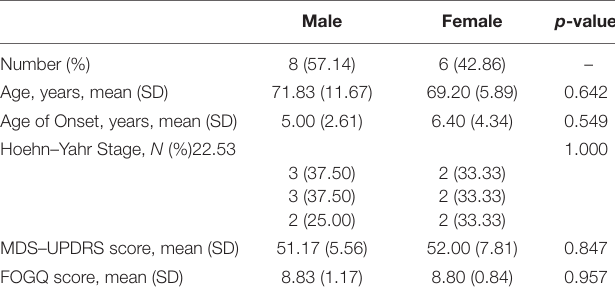
TABLE 1 | Characteristics of the included